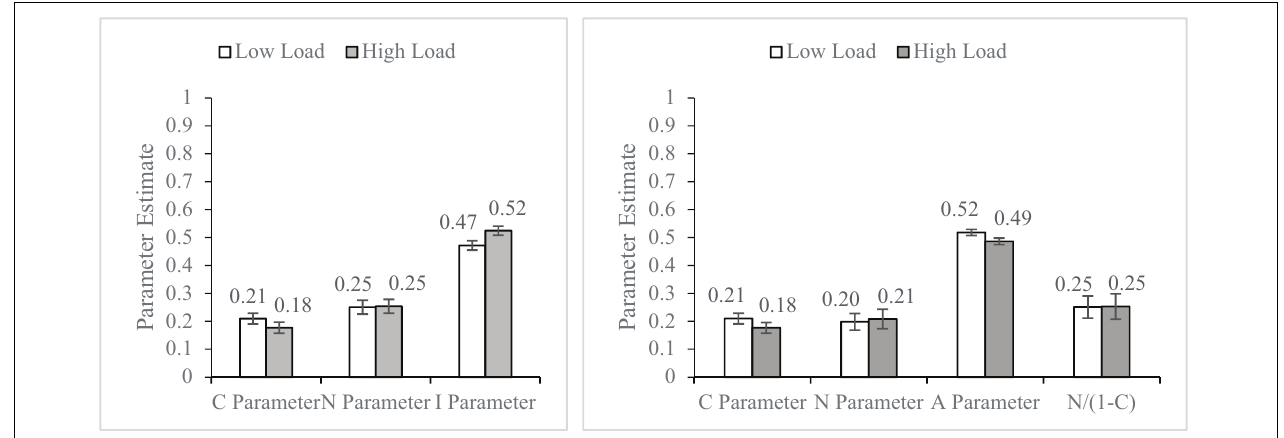
FIGURE A1 | Results of Study 2a by Gawronski et al. (2017) obtained from the CNI model (left) and CAN algorithm (right) . Error bars represent ± 1 SE.